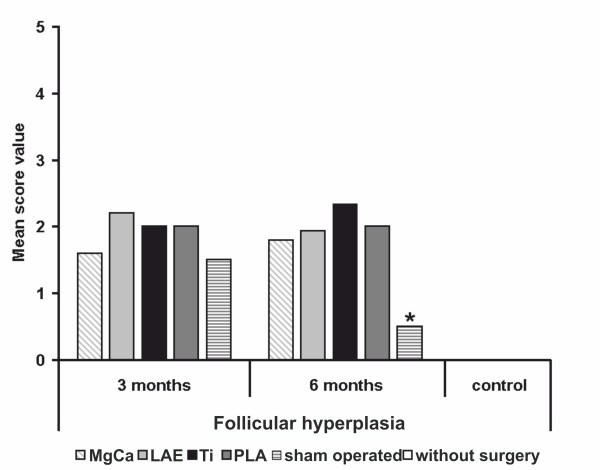
Score values of follicular hyperplasia for all examined groups. Note the absence of significant differences between all groups and evaluation times, except for the sham operated group after six months and the control group without surgery (* = p < 0.05). MgCa = MgCa0.8, LAE = LAE442, PLA = poly-96L/4D-lactide, Ti = TiAl6V4, sham operated = surgery without implant material, control = no surgery on the limb.